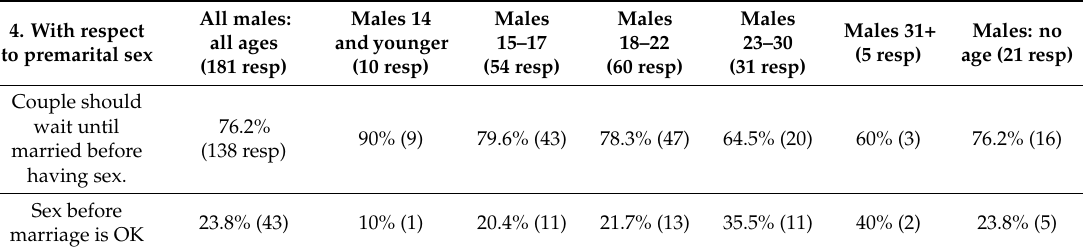
Table 9. Attitudes about Premarital Sex—All Males.